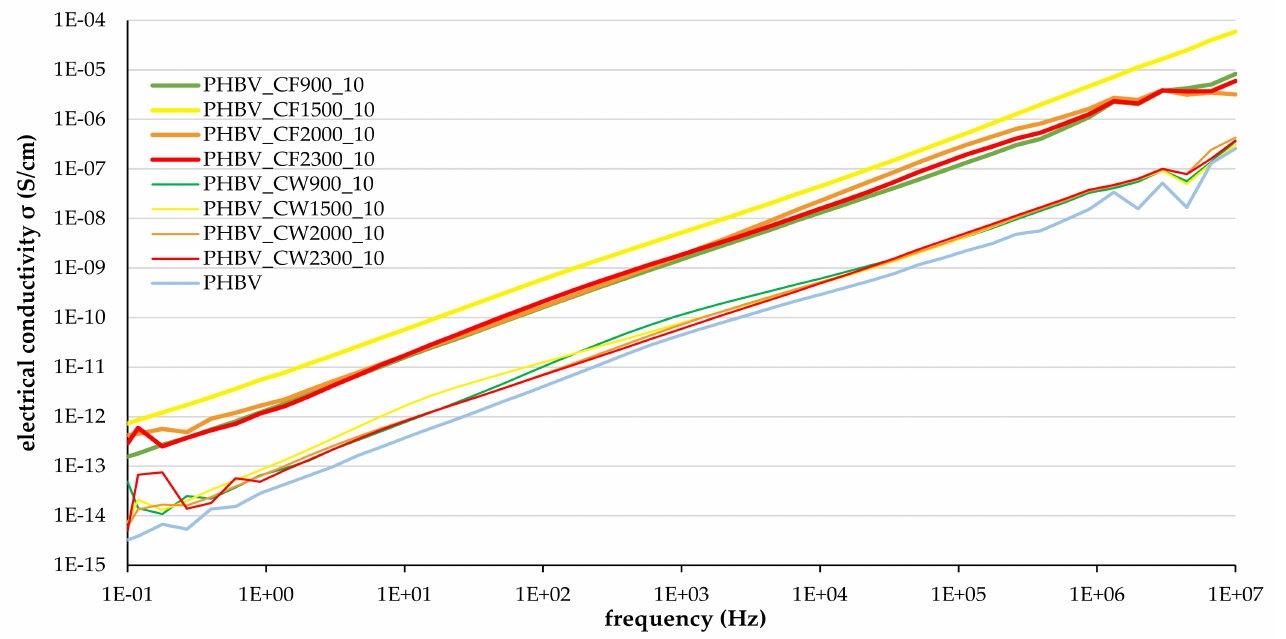
Figure 2. Relative mechanical performance in dependence of filler type and fill content. Tensile strength (TS), modulus (TM) and elongation at break (TE), impact strength (IS) and heat deflection temperature (HDT-A).